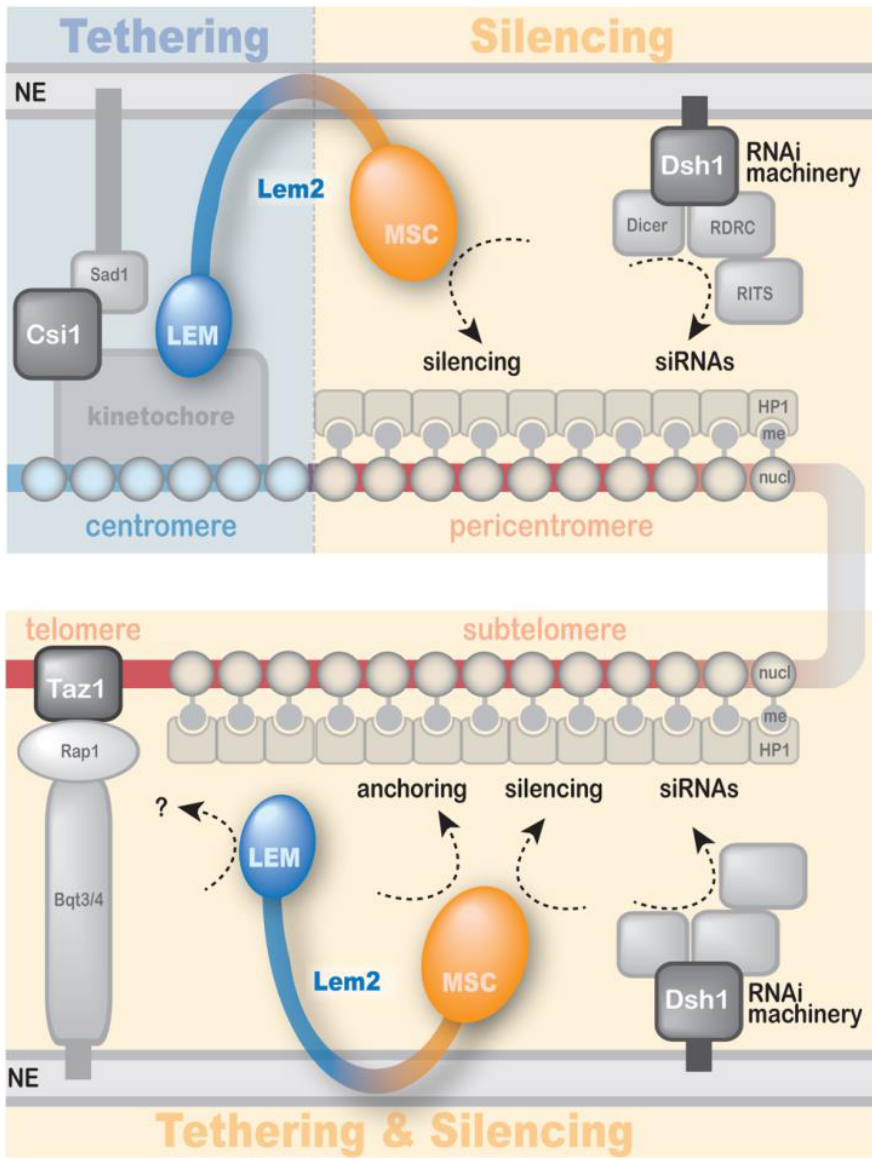
FIGURE 2: A model for Lem2 func- tion in heterochromatin localiza- tion and silencing. Lem2 mediates anchoring to the nuclear periphery of centromeres and telomeres through its LEM domain and MSC domain, respectively. Silencing of both heterochromatin domains is mediated exclusively through its MSC domain. Both functions coop- erate with other redundant path- ways (i.e. Csi1, RNAi, Taz1). See text for